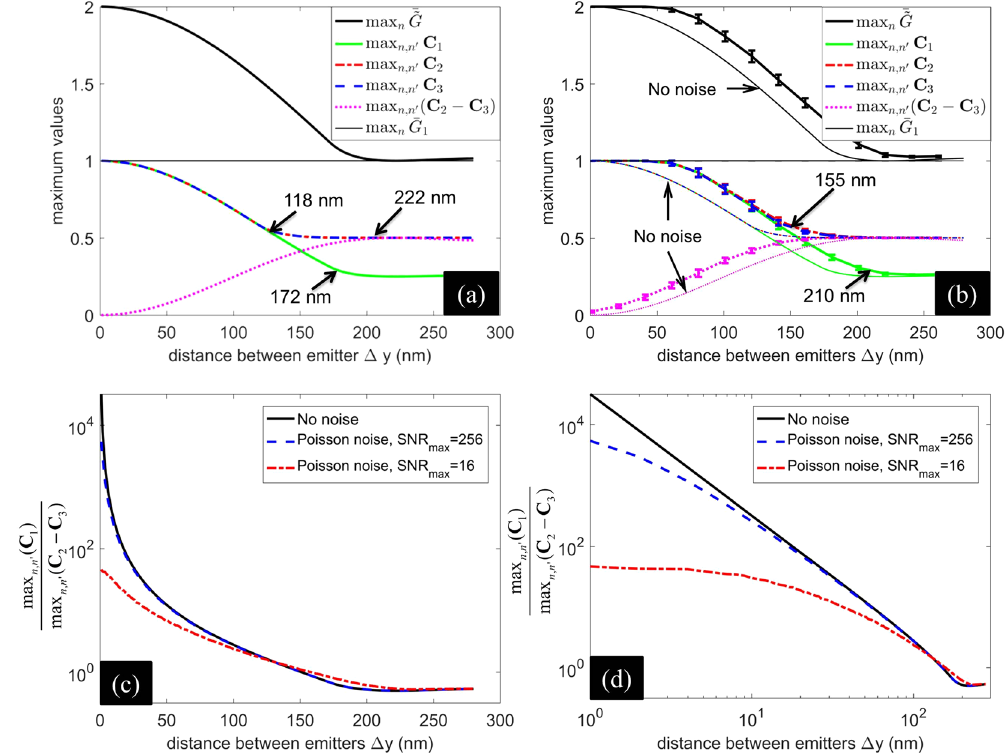
Figure 5. Comparison of magnitudes (maximum values) of matrices C 1 , C 2 , C 3 , and C 2 − C 3 is presented here. ( a ) Provides a direct comparison of magnitudes, assuming no measurement noise. ( b ) Compares their magnitudes for Poisson noise with maximum SNR 16. ( c ) Compares the ratio of the magnitude of C 1 to the magnitude of C 2 − C 3 . ( d ) is the same as ( c ) but with both horizontal and vertical axes in logarithmic